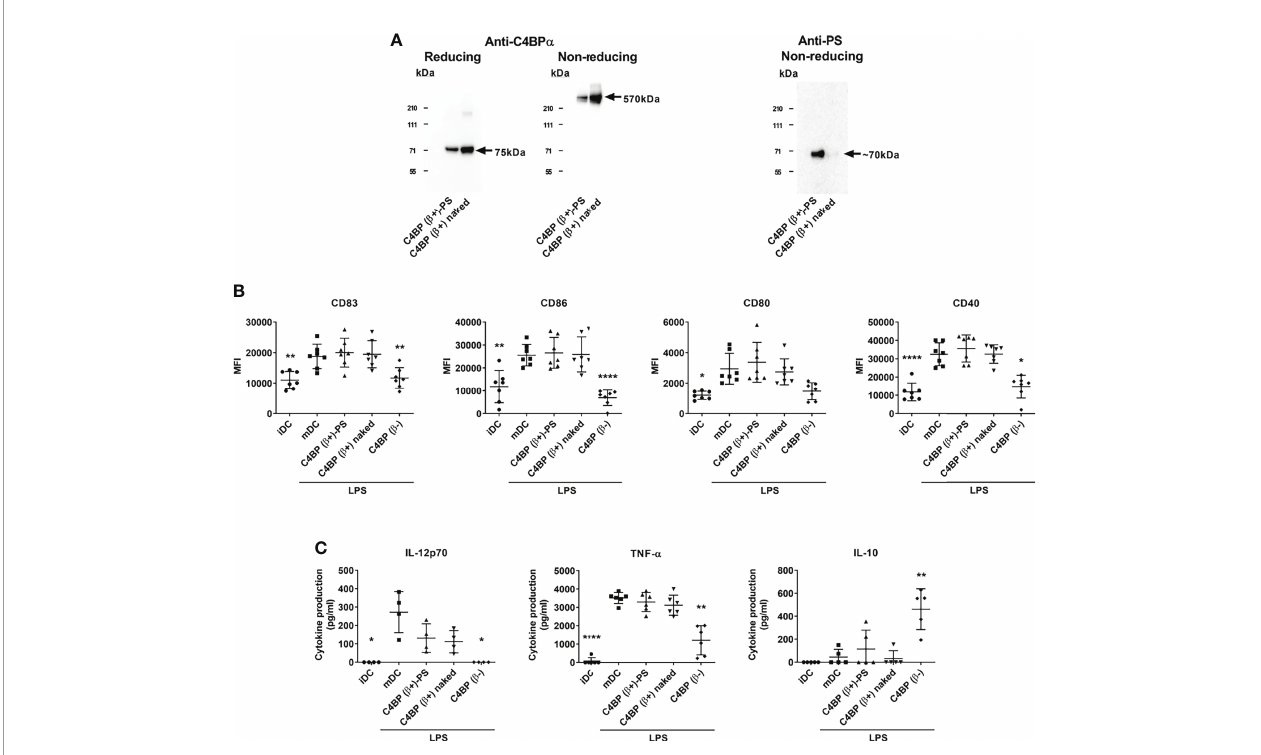
FIGURE 1 | The b -chain of C4BP impairs the immunomodulatory activity of its internal CCP6 a -chain domain. (A) SDS-PAGE and Western analysis of the major physiological C4BP isoform (C4BP( b +)) complexed with PS (C4BP( b +)-PS) through its b -chain, and the same C4BP( b +) isoform devoid of PS (C4BP( b +) naked). Both proteins were resolved under reducing (left) and non-reducing (middle) conditions and probed with PK9008 anti-C4BP a -chain antibody. A further Western blot probed with an anti-PS antibody con fi rmed the absence of PS in the “ C4BP( b +) naked ” form (right). (B) Human Mo-DCs were incubated throughout their differentiation process with C4BP( b +)-PS, C4BP( b +) naked and C4BP( b -), all at 12 nM (corresponding to 6.0 m g/ml, 5.3 m g/ml, and 5.0 m g/ml, respectively). DC maturation was achieved by LPS treatment. Cells were then collected, washed, and analyzed by fl ow cytometry for cell surface expression of the activation marker CD83 and the co-stimulatory molecules CD86, CD80 and CD40. MFI, median fl uorescence intensity for the different surface markers. (C) The concentrations of IL-12p70, TNF- a and IL-10 were analyzed in the respective cell supernatants by ELISA. iDC, untreated, immature DCs; mDC, untreated, LPS-matured DCs. The results shown are the mean ± SD from 7 independent donors (cell surface markers), or from 4-6 independent donors performed in duplicate (cytokines) (*p < 0.05; **p < 0.01; ****p < 0.0001 compared with mDC). IL-12p70 concentrations induced by C4BP( b +)-PS and C4BP( b +) naked appeared reduced but were not statistically signi fi cant compared to that induced by mDC (p = 0.082, and p = 0.053,